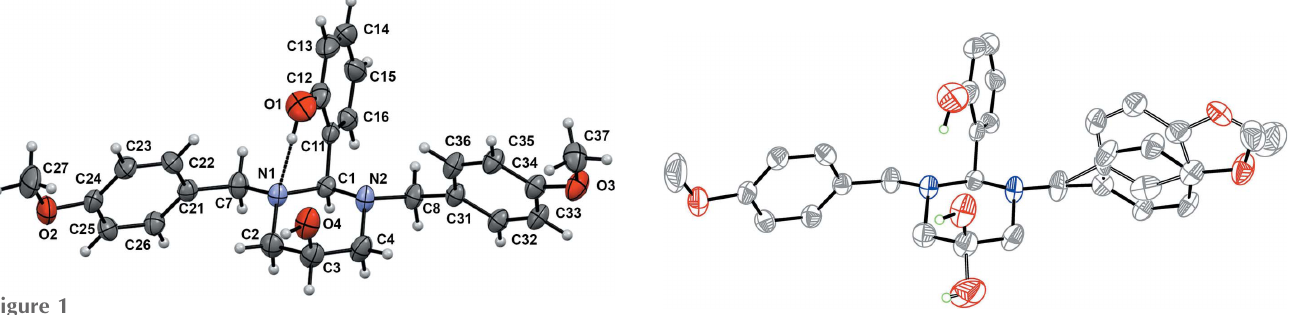
Figure 2 Overlay image of the molecular disorder of the title compound. The major occupancy sites are drawn with full bonds, while the minor occupancy sites with open bonds